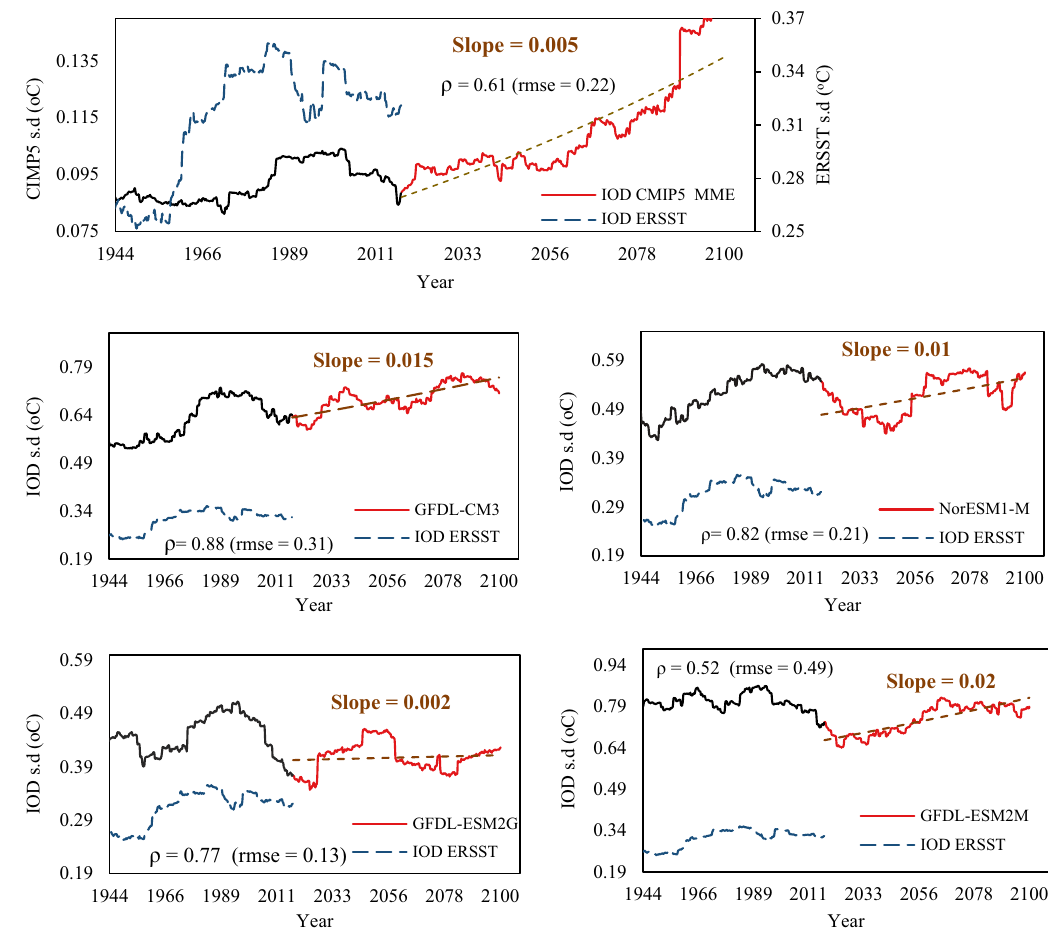
Figure 12. Time variation of simulated IOD amplitude. ( a ) the multi-model ensemble (MME) of the IOD. The MME IOD was computed as the difference between West (50° E–70° E and 10° S–10° N) and Eastern (90° E–110° E and 10° S–0° N) SST of the Indian ocean from 34 climate models. The 30-year running IOD amplitudes from ERSST over the period 1913–2017 are also shown (blue lines). There is significant correlation between the IOD calculated from the MME and ERSST observations (ρ =